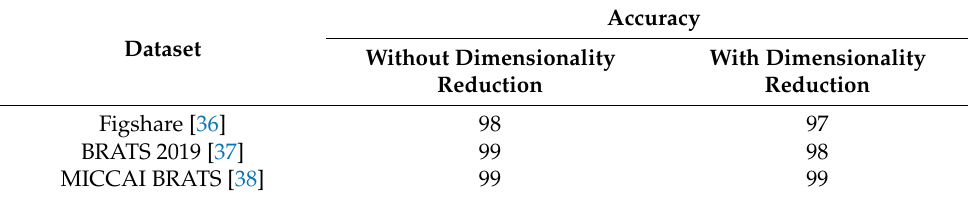
Table 3. Comparison of segmentation accuracy with and without dimensionality reduction on different